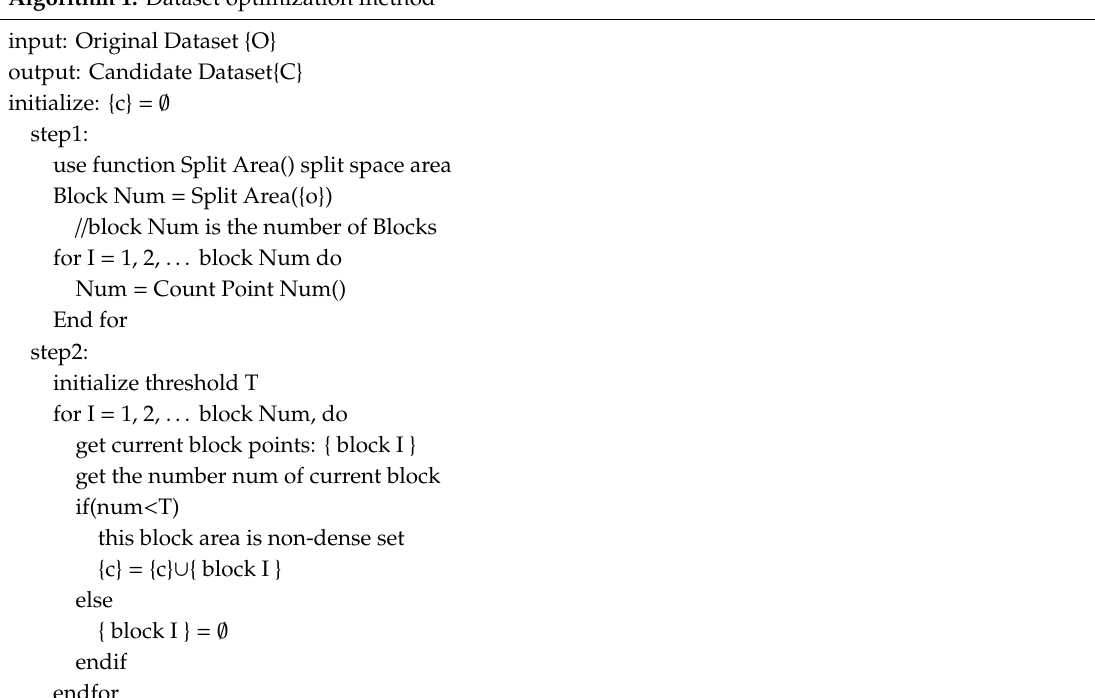
Algorithm 1. Dataset optimization